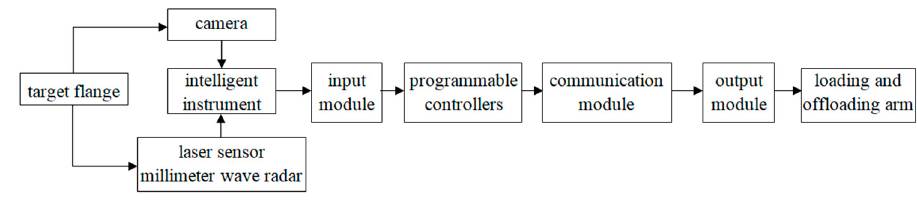
Figure 3. Block diagram of the working principle of the system.